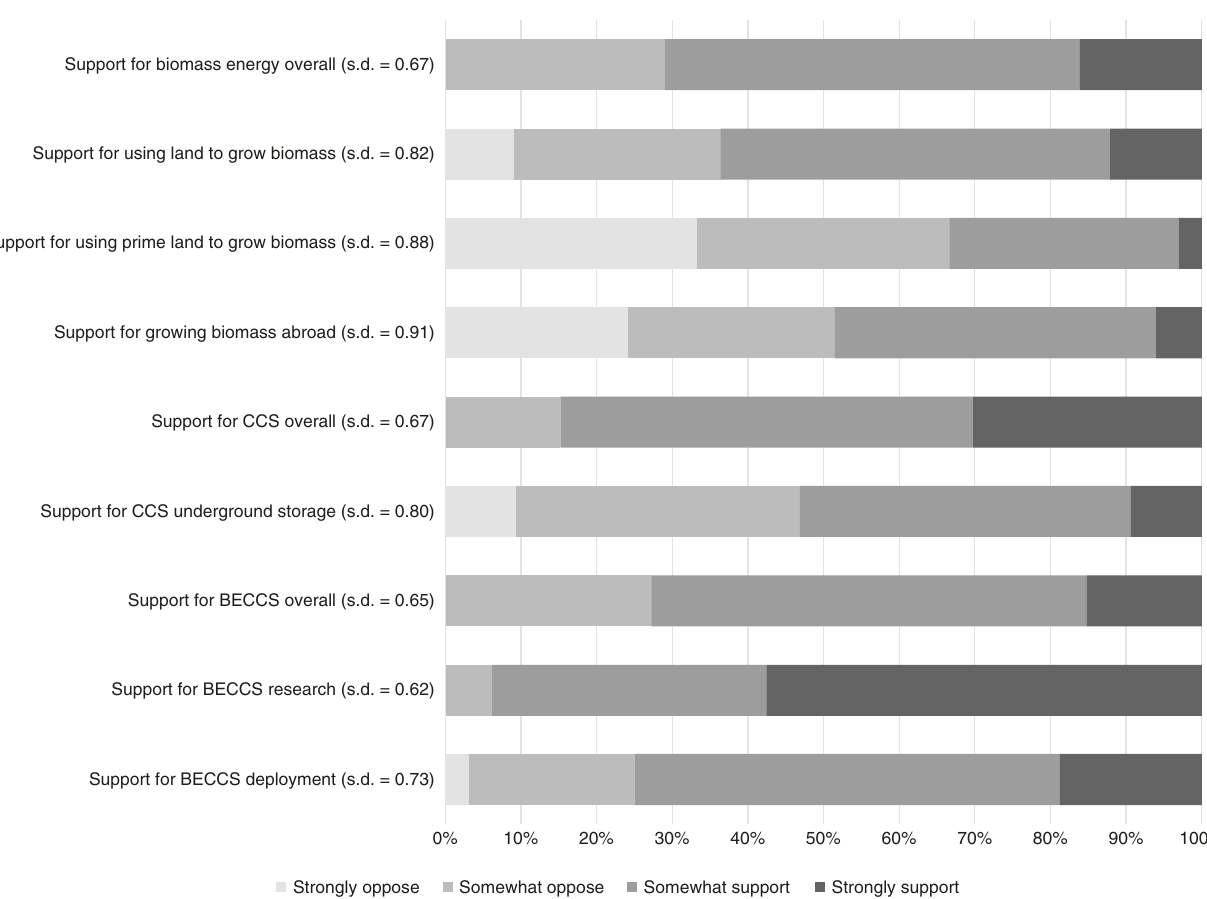
Fig. 1 Support for different dimensions of bioenergy with carbon capture and storage at the start of the experiment (% of participants, n = 33). Attitudes were elicited on a four-point scale (1 = strongly oppose, 2 = somewhat oppose, 3 = somewhat support, 4 = strongly support). The questions to which each dimension of BECCS pertains can be found in Supplementary Note